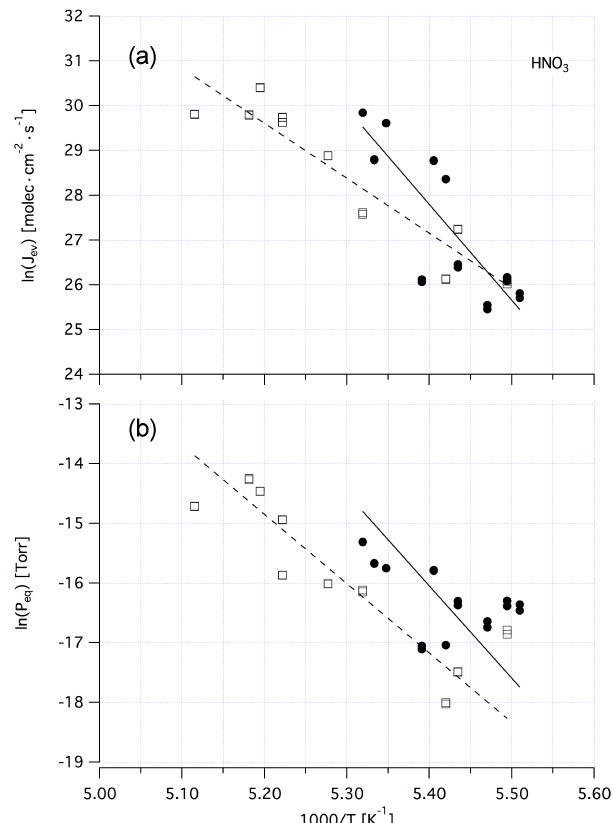
Figure 13. Arrhenius plot of J ev (HNO 3 ) (a) and van’t Hoff plot of P eq (HNO 3 ) (b) for α -NAT (Fig. 2b and c) and β -NAT (Fig. 4b and c) resulting from TO experiments. Full black circles and empty black squares represent the interaction of HNO 3 with α - and β -NAT films, respectively. The equations for the fitting lines may be found in the